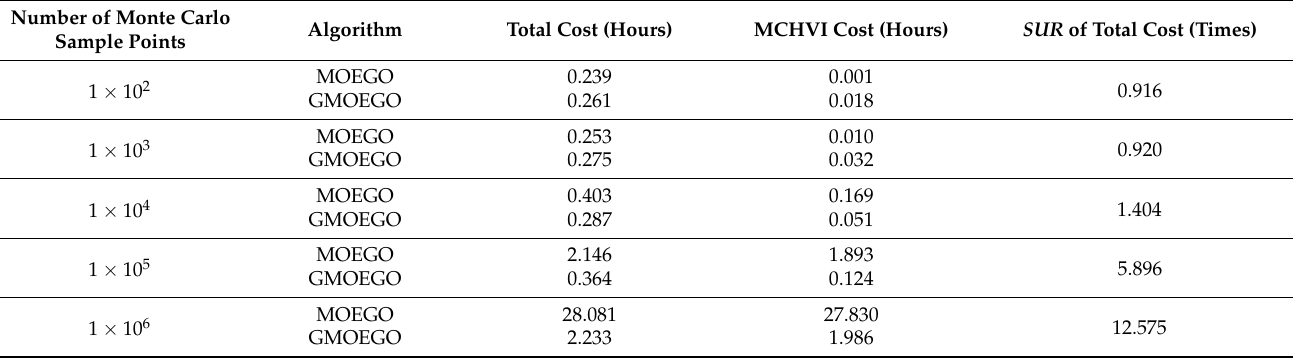
Table 1. Test results of the speedup ratio of